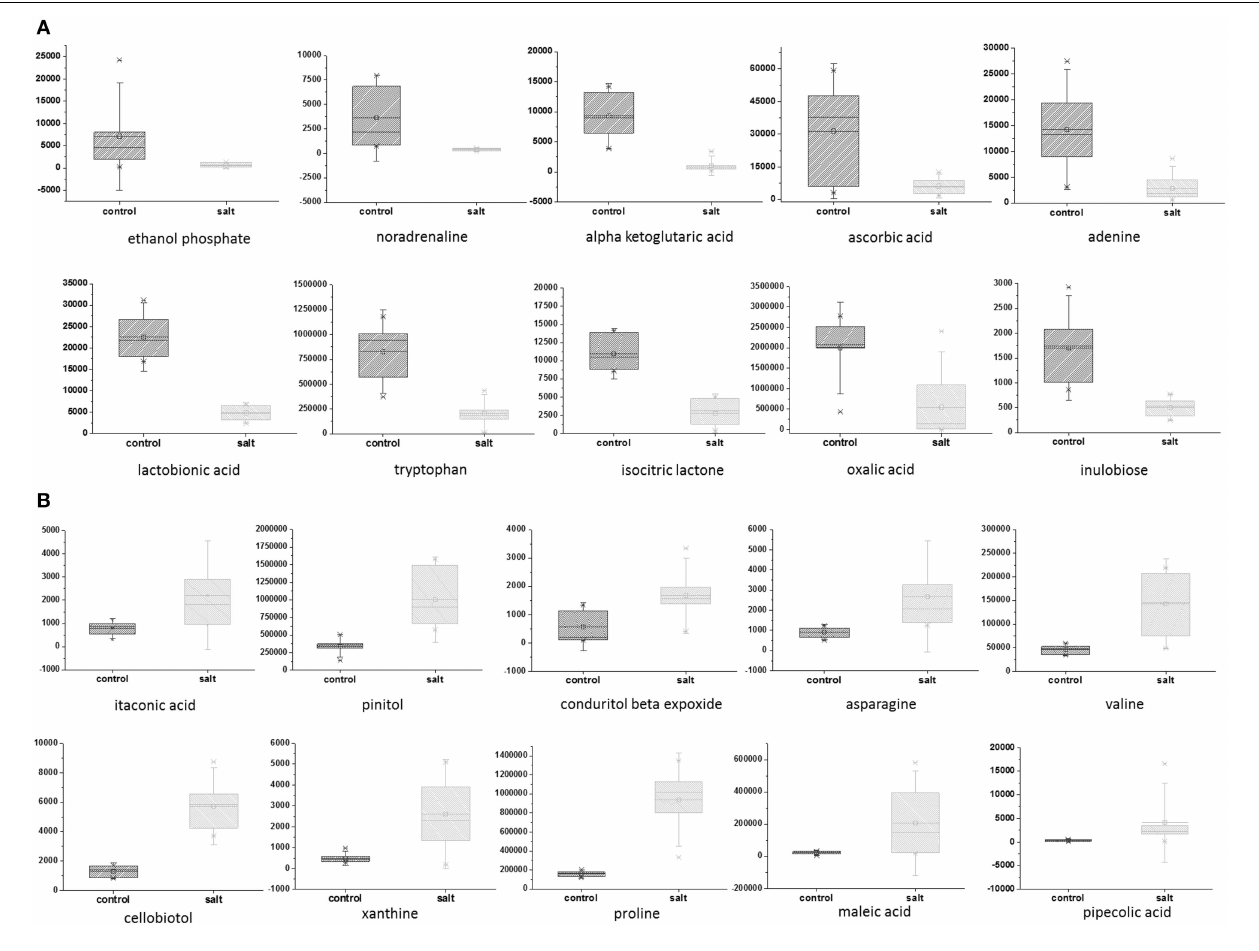
FIGURE 1 | Top 10 down- and up-regulated metabolites in EBC extracts from salt-treated plants compared to control plants. Metabolites which were significantly down-regulated (A) and upregulated (B) , as determined by a two-sample t -Test. The probability or significance level for